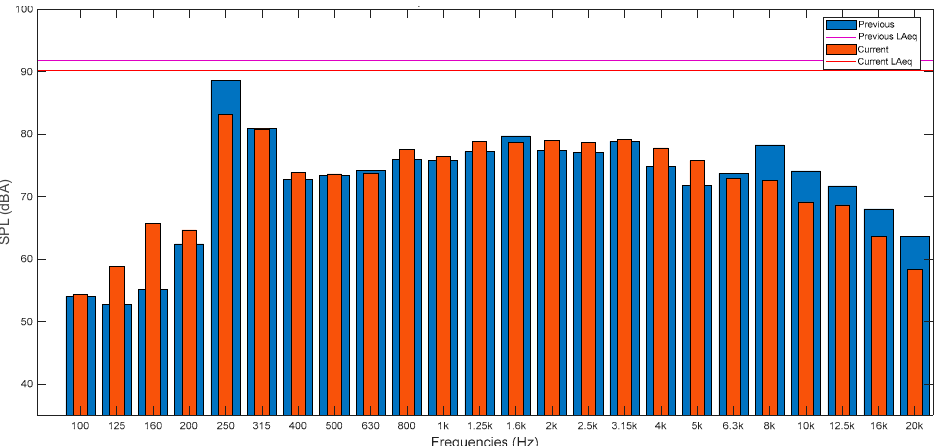
Figure 12. Results of the sound reduction redesign showing a bar plot of 1/3 octave noise measurements with dBA (A-weighted decibels) weighting.